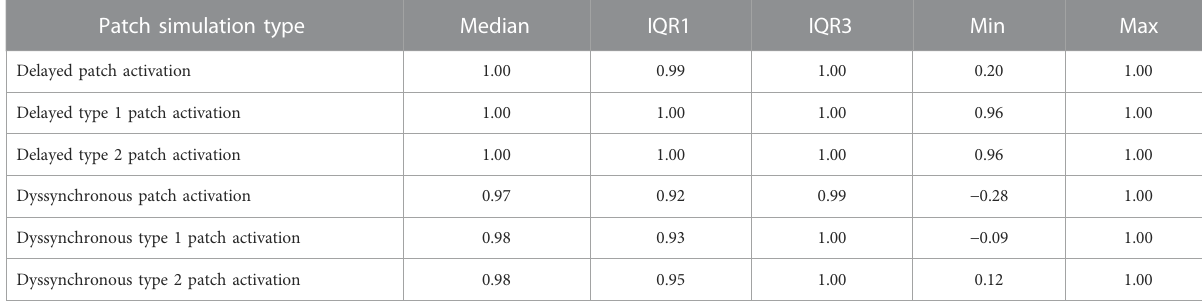
TABLE 2 Overview of simulation characteristics and resulting